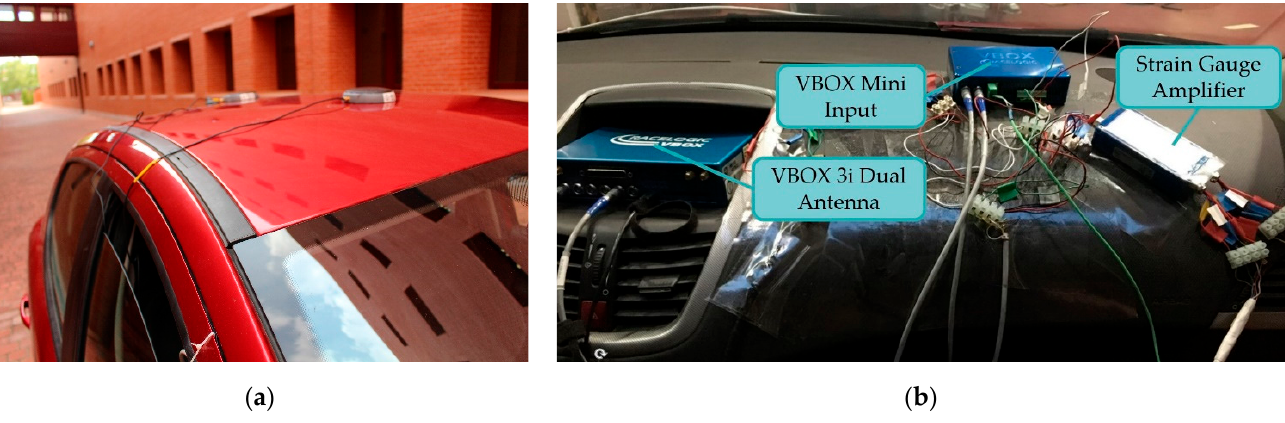
Table 1. Tests carried out by different drivers.